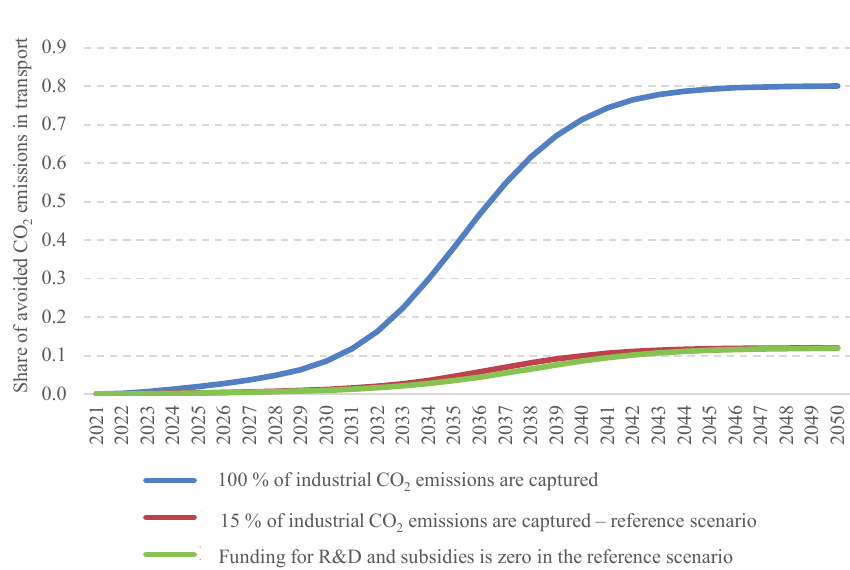
Fig. 7. Dynamics of the share of avoided CO 2 emissions in transport depending on the fraction of industrial (including energy production) CO 2 emissions that are captured as well as funding for R&D and subsidies.